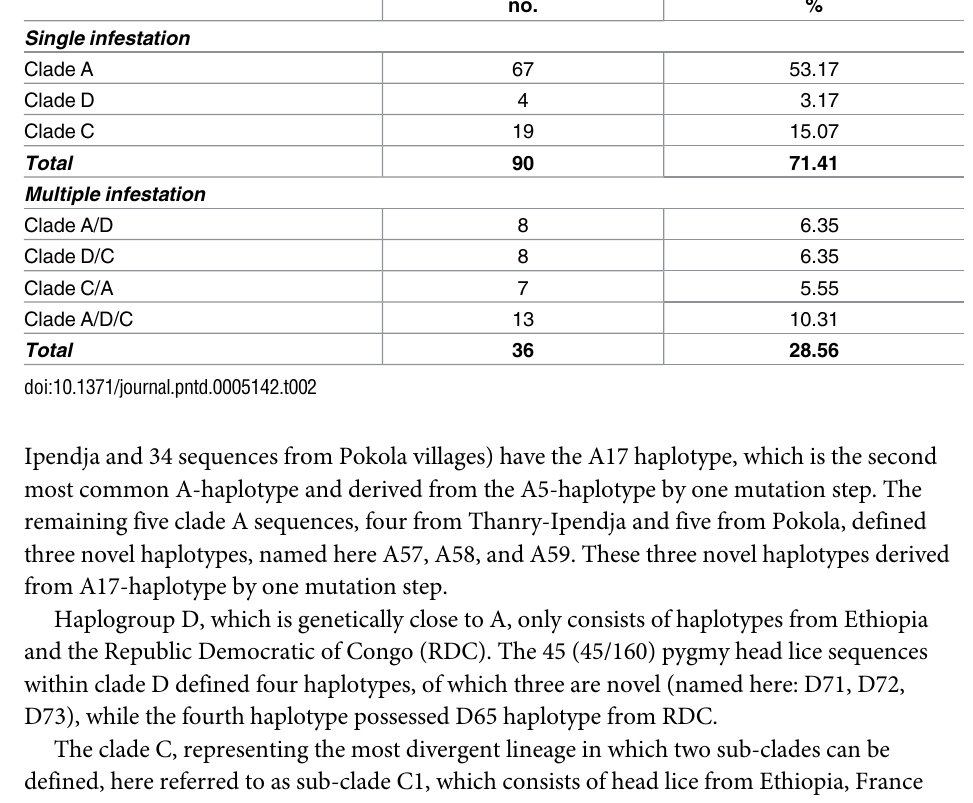
Table 2. Number of pygmy individuals infested with single or multiple clades of lice from Congo- Brazzaville.